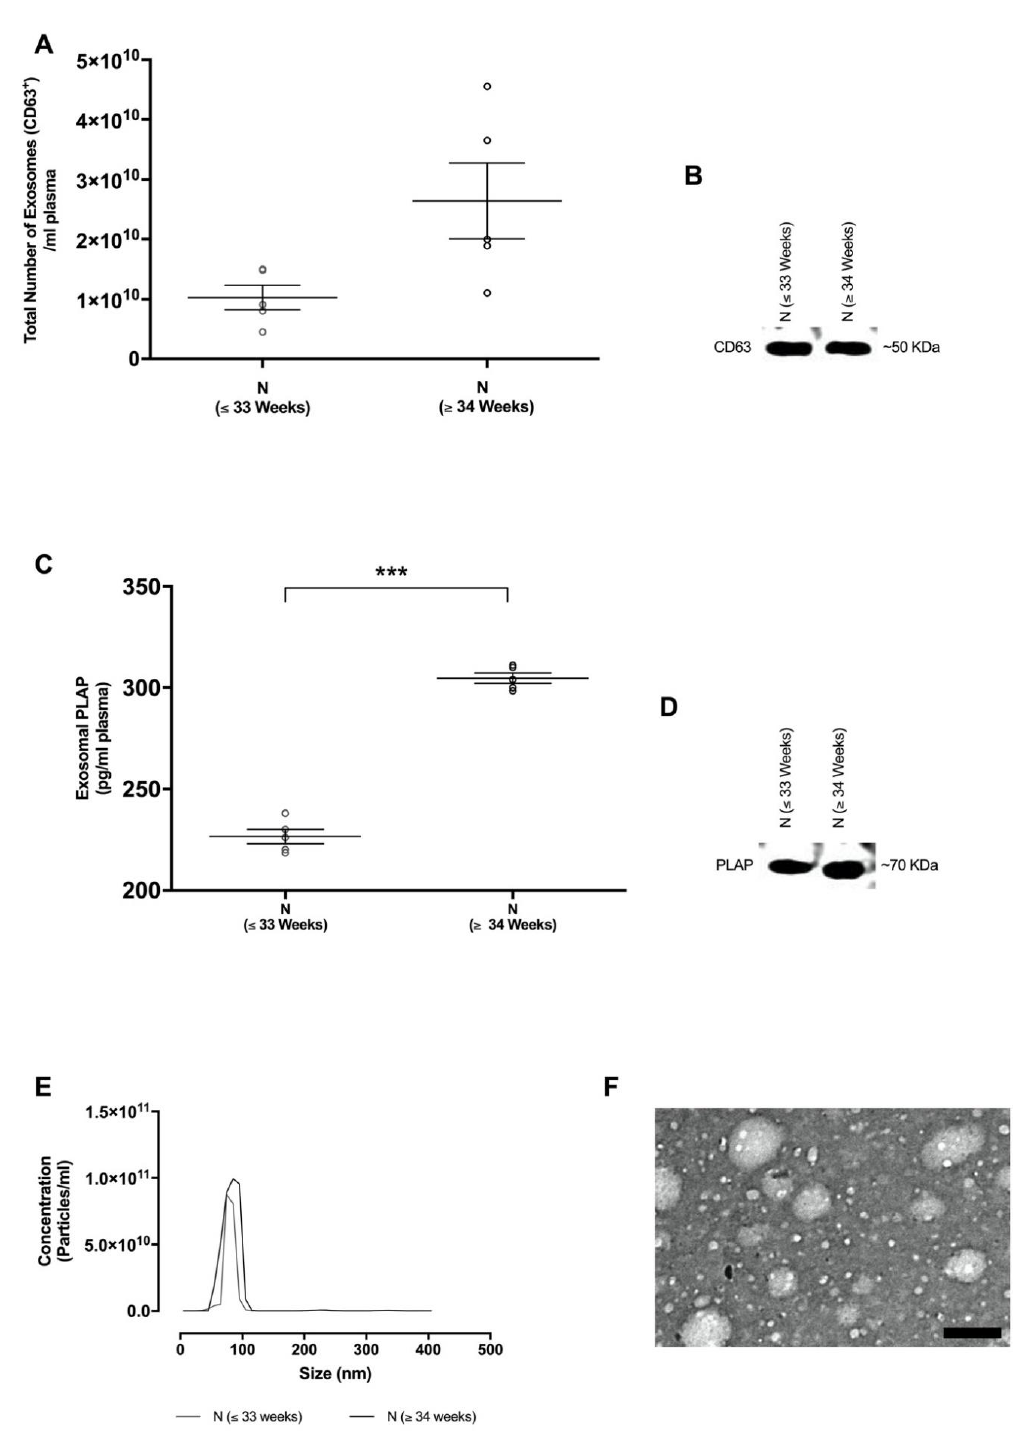
Figure 1. Identification and characterisation of exosomes from normotensive pregnant women. ( A ) Total exosome concentration was determined by the quantification of the exosomal CD63 marker per mL of plasma using ELISA. ( B ) Western blot analysis for the CD63 exosome enriched marker. ( C ) Placenta-derived exosomes (i.e., exosomal placental alkaline phosphatase (PLAP) was quantified per mL of plasma by ELISA. ( D ) Western blot analysis for the exosomal PLAP marker. ( E ) Nanoparticle tracking analysis (NTA) illustrating the representative vesicle size distribution (nm). ( F ) Electron micrograph of isolated exosomes, scale bar 100 nm. In A , C , the data are expressed as aligned dot plots and values are mean ± SEM. *** p < 0.0001 N ( ≤ 33 weeks) vs. N ( ≥ 34